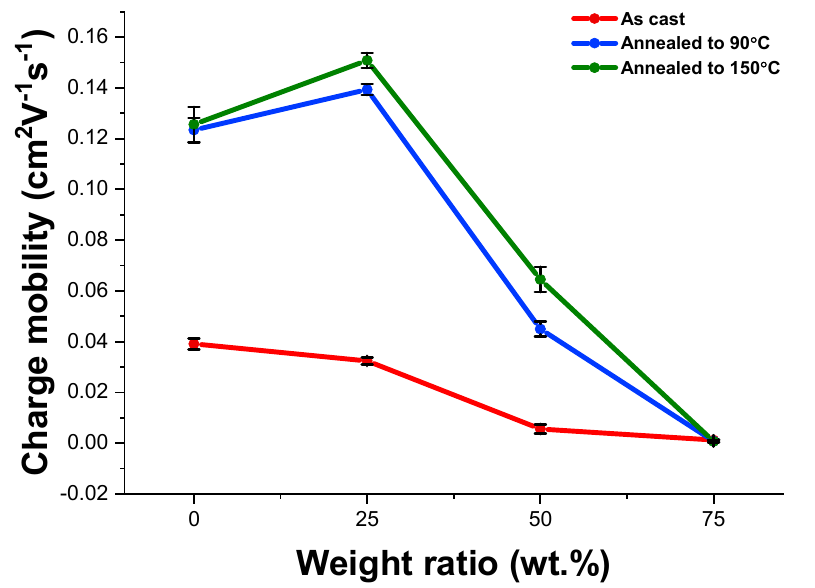
Figure 2. Average charge carrier mobility of different P(DPPTVT):LPE blends for thin films as-cast, after thermal annealing at 90 °C, and after thermal annealing at 150 °C.